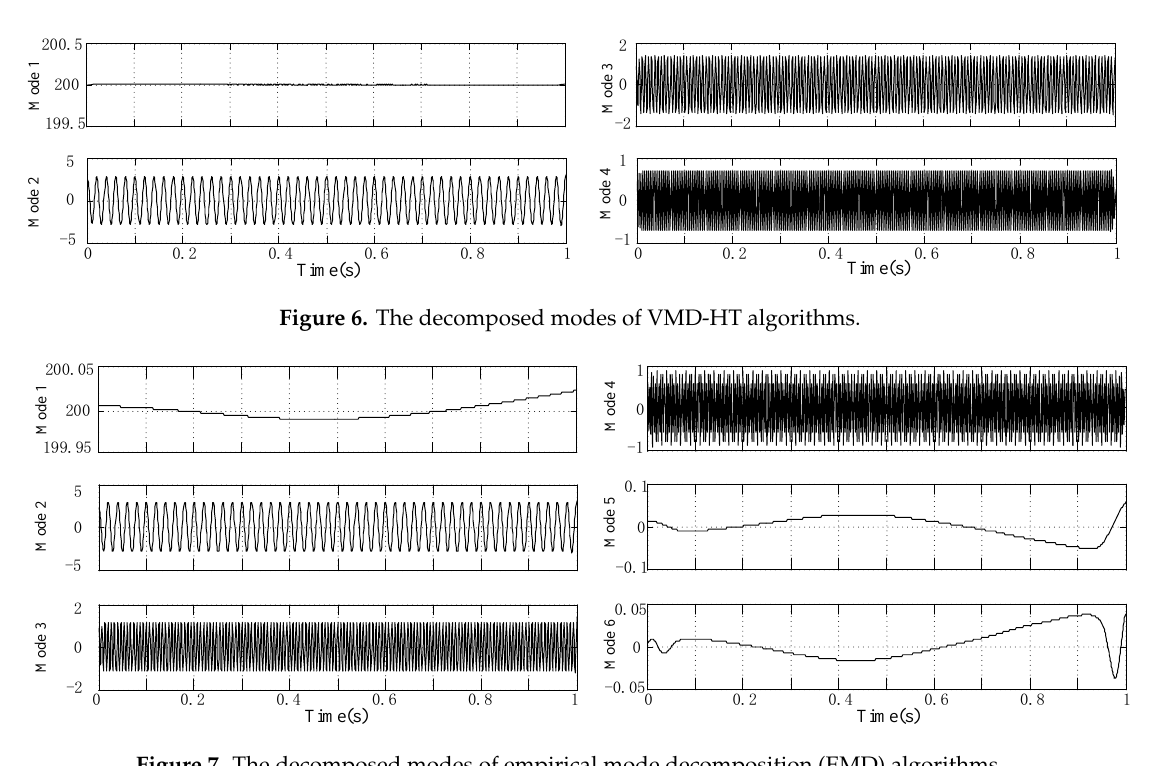
Figure 7. The decomposed modes of empirical mode decomposition ( EMD) algorithms .